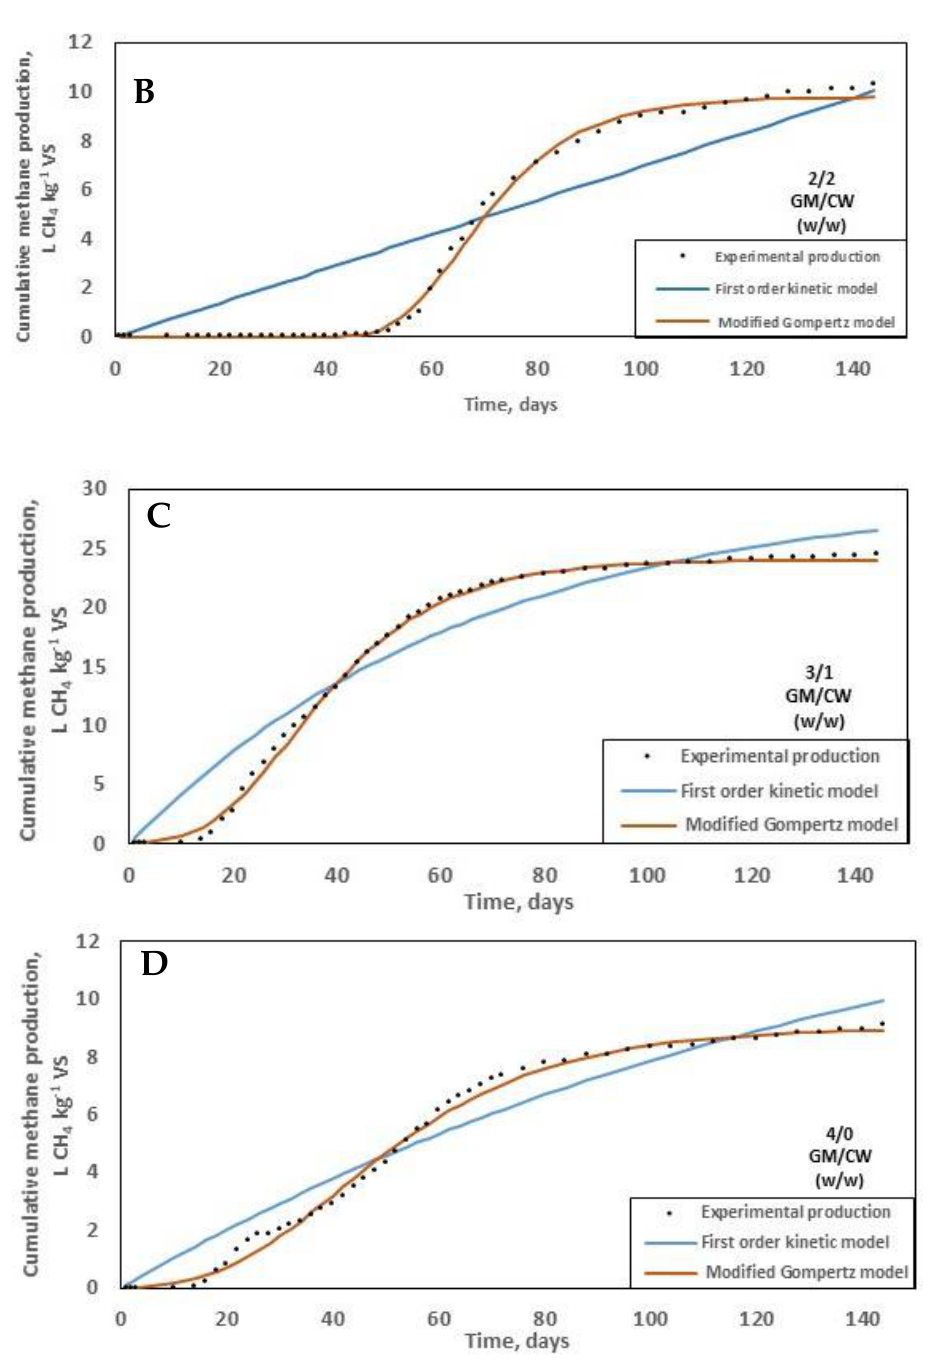
Figure 3. Plot of simulated predictive cumulative methane yield (L CH 4 kg − 1 VS) against experimental values obtained using first-order linear model (blue) and the modified Gompertz model (orange) for digesters containing: 1 / 3 GM / CW ( w / w ) ( A ); 2 / 2 GM / CW ( w / w ) ( B ); 3 / 1 GM / CW ( w / w ) ( C ); and 4 / 0 GM / CW ( w / w ) ( D ).